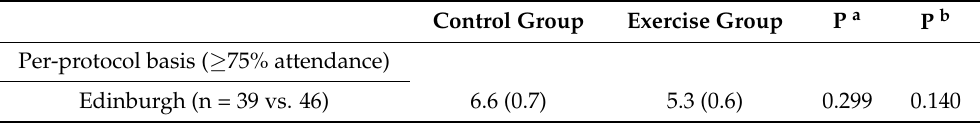
Table 2. Influence of the exercise intervention on postpartum